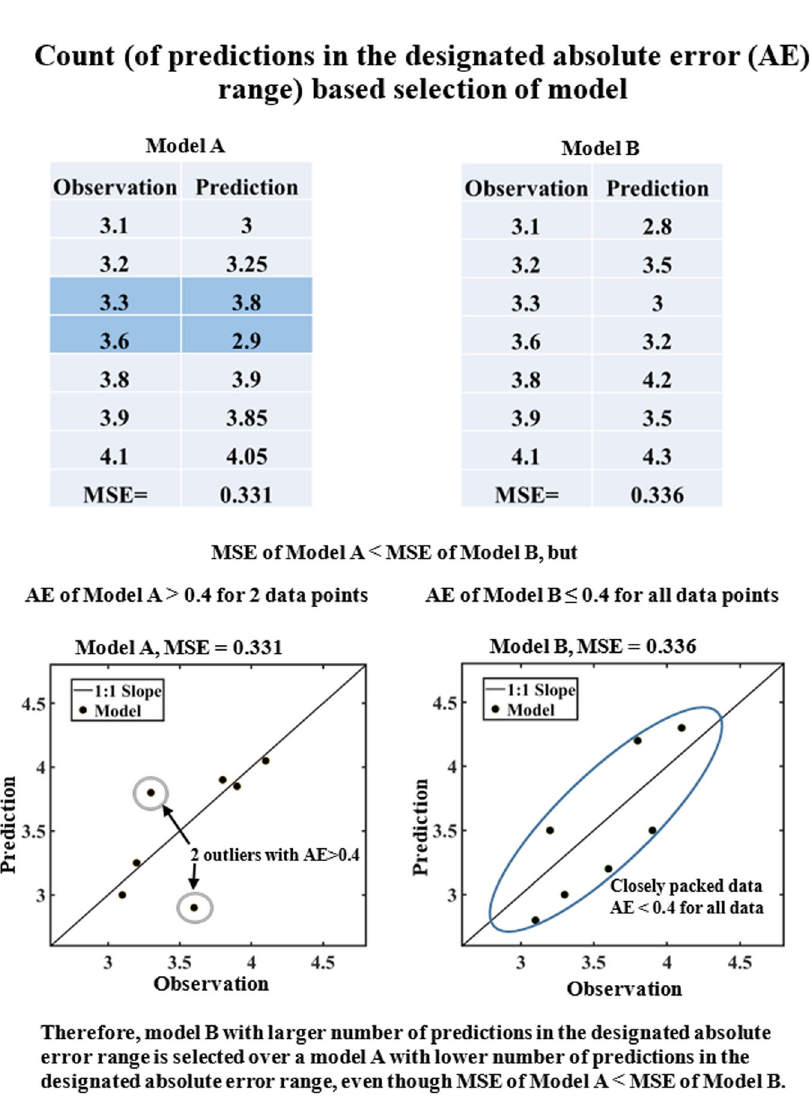
Fig. 7 A simpli fi ed illustration of the count (of predictions in the designated AE range) based selection of model: predictions of model A have smaller MSE than that of model B. However, the predictions of model B have a low AE ≤ 0.4 for all data as compared to model A that has AE > 0.4 for 2 data points. Hence, model B is more advantageous in making a greater number of good predictions than fewer more accurate predictions as done by model A. We, therefore, adopt this criterion for selecting the best model here. Data shown here for illustrative purpose only.